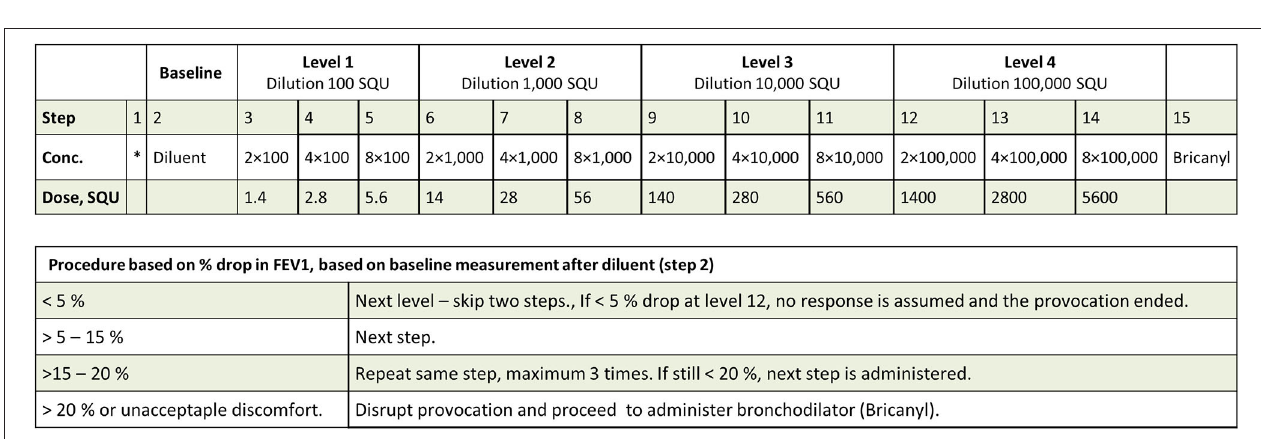
FIGURE 1 | Study design (above) and timeline (below), depicting the specific inhalation challenges (SICs) and the daily pollen counts measured at the operational trap in the city of Viborg (below), normalized across the 3 years and two pollen species.